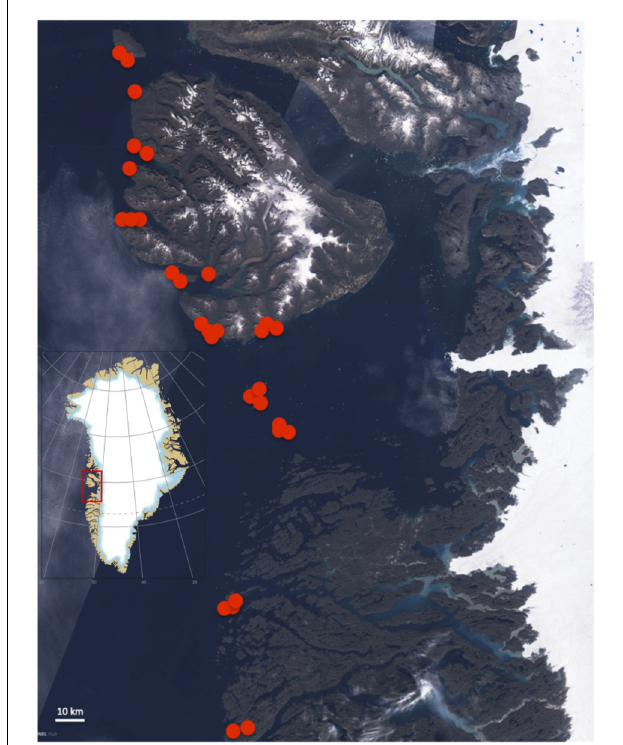
FIGURE 1 | Map of stations representing this study’s observations of depth limits of Greenland kelp along the outer shores of the Disko Bay area, 67–70 ◦ N, on Greenland’s west coast. The satellite image shows plumes of turbid water in the inner parts of fjords and clear waters along the outer shores although some clouds cover part of the